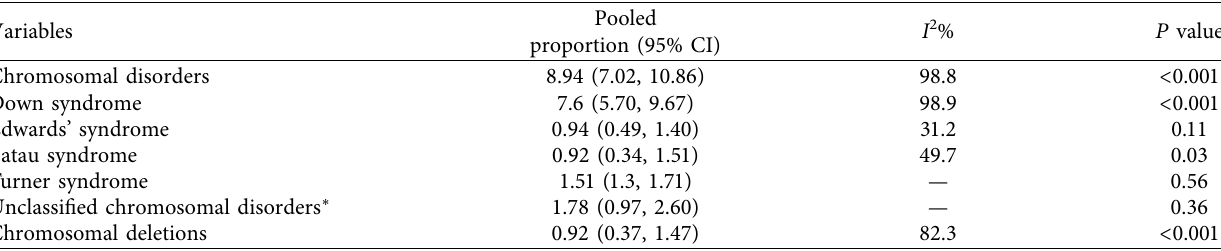
Table 3: Pooled proportion and patterns of chromosomal disorders among births with congenital anomalies in Africa from January, 2000 to October, 2021.